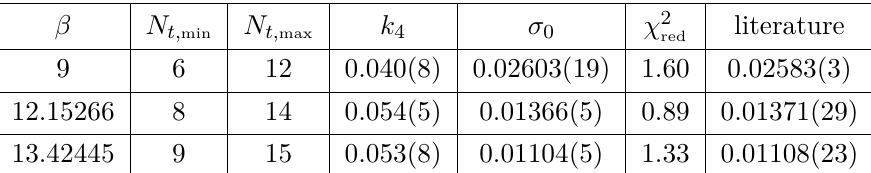
Table 10 . Results of the fits of our numerical data to eq. (6.7). In the last column we report the values of σ quoted in ref. [36] for β = 9 , and in ref. [32] for β = 12 . 15266 and for β = 13 . 42445 0